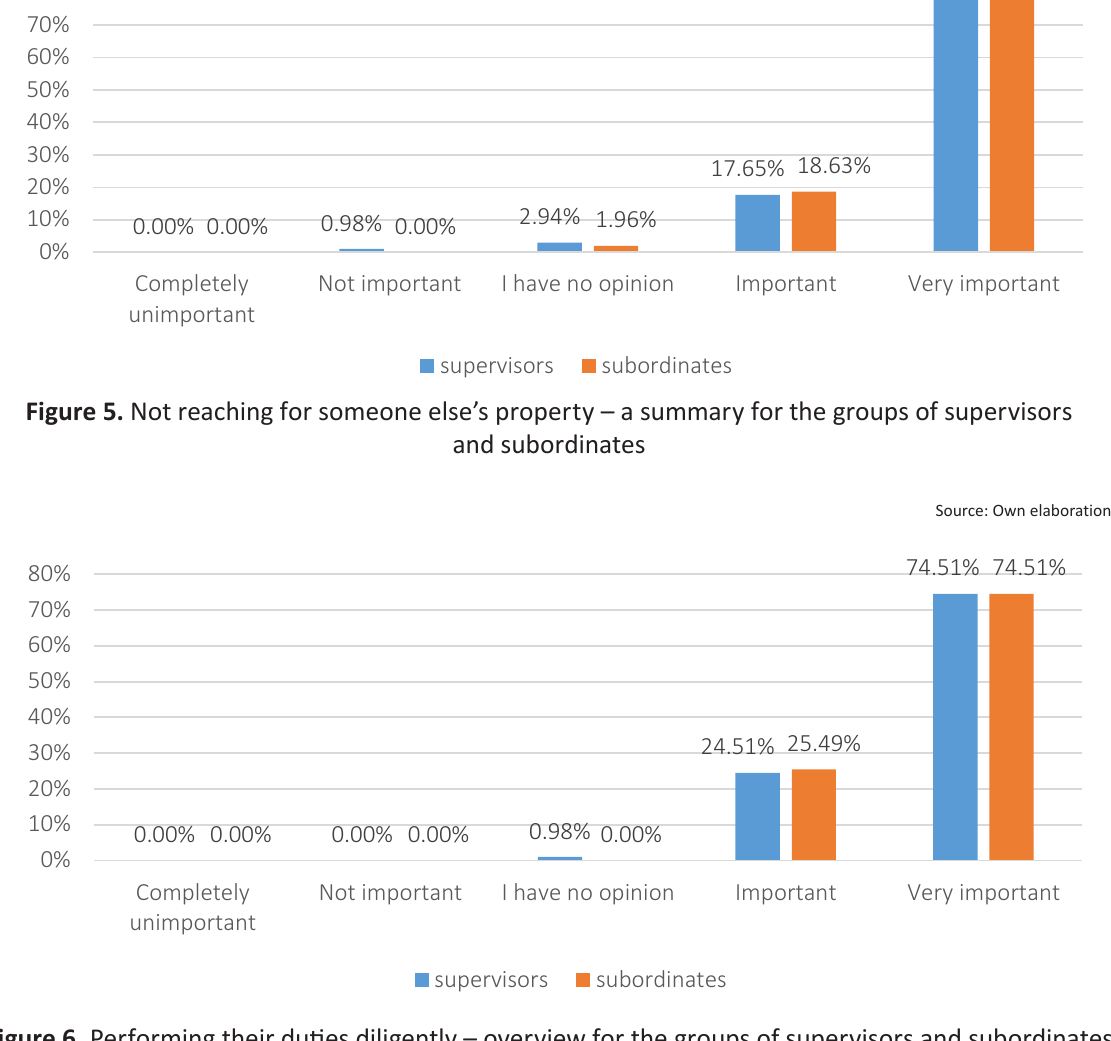
Figure 6. Performing their duties diligently – overview for the groups of supervisors and